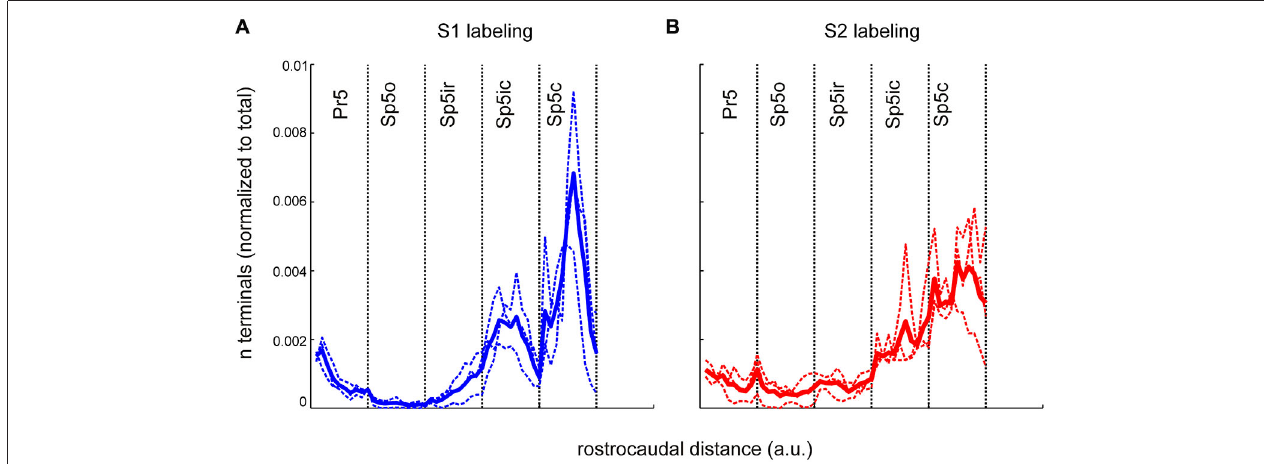
FIGURE 5 | The rostrocaudal distribution of labeled terminals from S1 and S2 cortical injections across the different trigeminal sensory nuclei. (A) The binned terminal counts resulting from an anterograde injection into the S1 cortex of three rats. Each nucleus, irrespective of its actual rostrocaudal extent, has been binned into 10, equally spaced bins. The width of each bin varies according the rostro-caudal extent of each nucleus with Pr5 bins being the smallest. Dotted lines show the binned terminal counts averaged across all sections, for each animal. Thick line denotes the mean of these averages across animals. (B) Identical plot of terminal distribution from the S2 injection. a.u., arbitrary units.